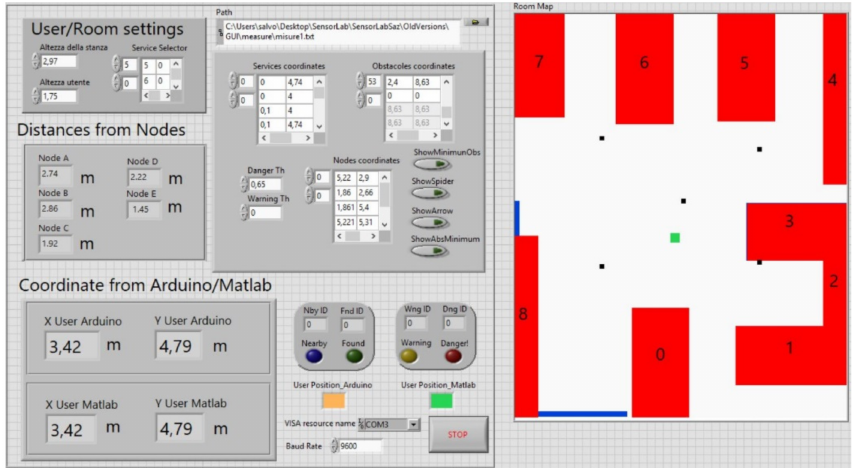
Figure 2. The System Management